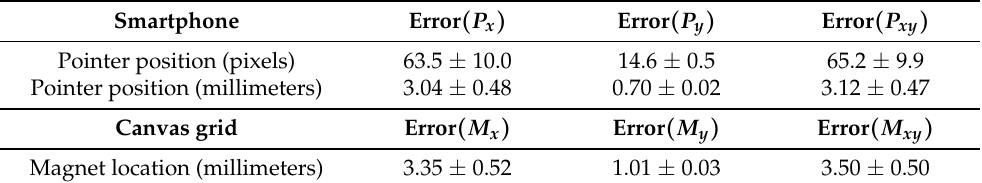
Table 3. Estimation errors of the NN models (based on MAE values), expressed in physical measures, for both the smartphone pointer position and the magnet location.